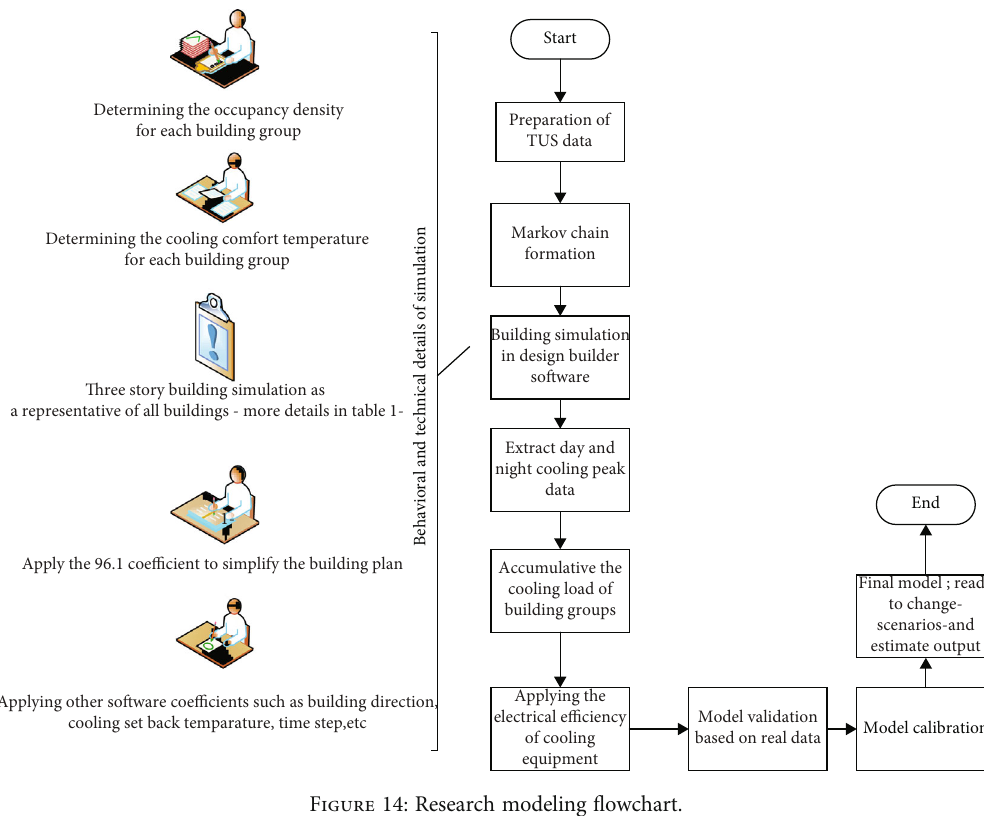
Figure 14: Research modeling fl owchart.